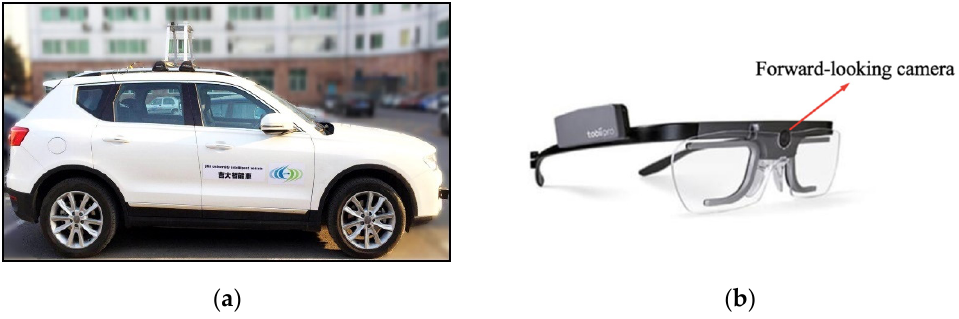
Figure 1. Experimental equipment: ( a ) Harvard H7 vehicle and ( b ) Tobii Glasses 2 eye tracker.